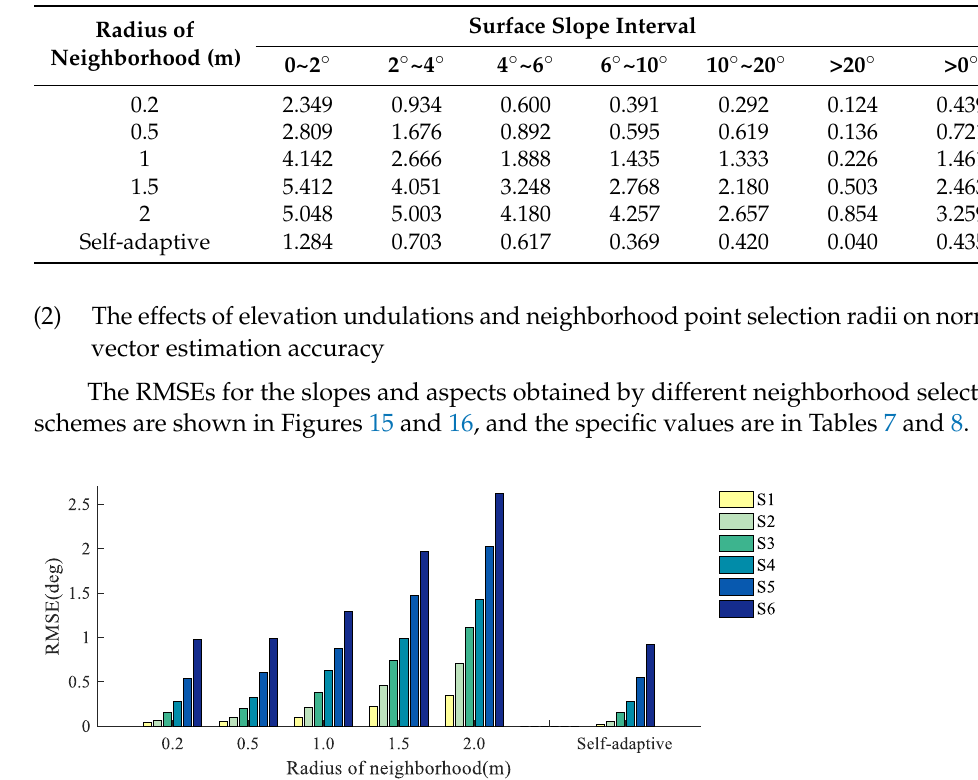
Table 6. Root mean square error of wave surface aspect estimation in different intervals.